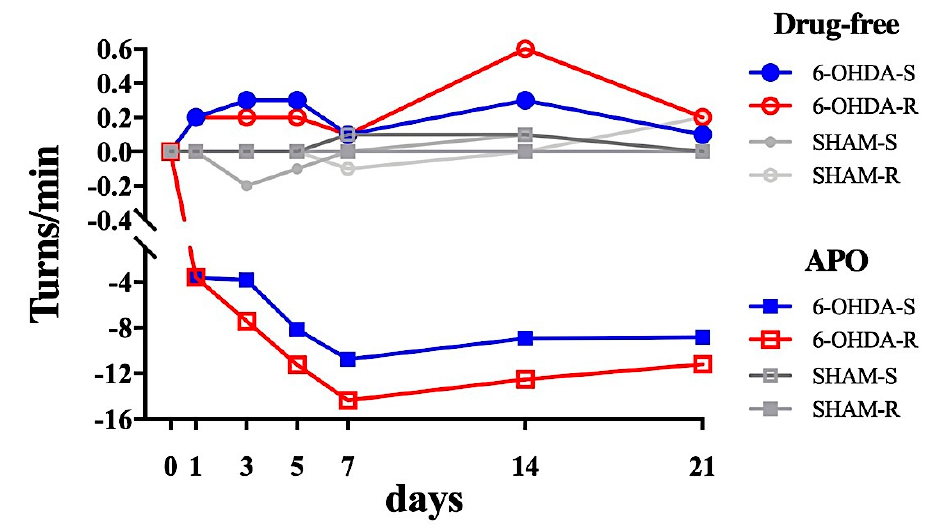
Figure 2. Time course of the number of turns/min assessed by the rotational test (RT) for the SHAM and 6-OHDA lesioned rats in drug-free (circles) and apomorphine (APO, squares) induced condition. Day 0 represents the pre-surgery testing. Positive values indicate ipsilateral turns/min; negative values indicate contralateral turns/min. See Supplementary Table A2 for the statistical difference between 6-OHDA and SHAM groups, and between time points to the pre-surgery condition (day 0).